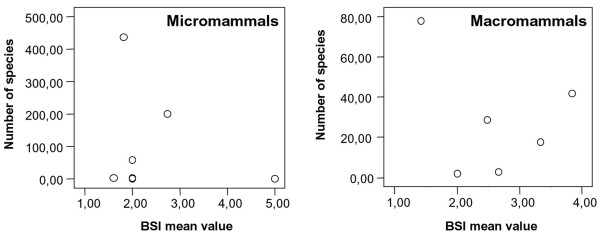
Relationship between BSI mean value and number of species in each clade of micro- and macromammals.